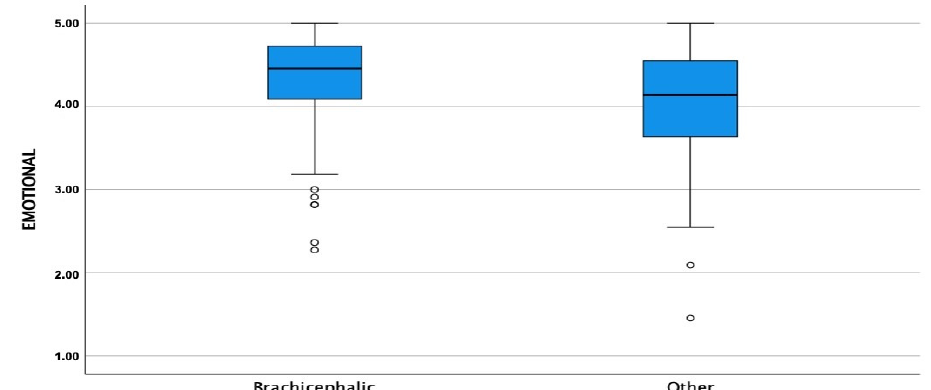
Figure 1. Comparison of cat-owner interaction subscale (COI) means between brachycephalic and non-brachycephalic breeds. Dots represent weak outliers; stars represent strong outliers.